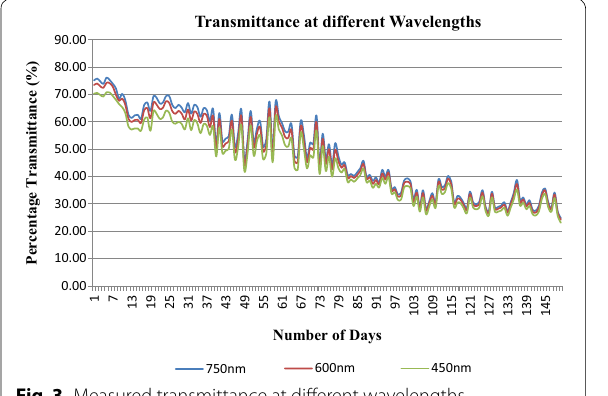
Fig. 3 Measured transmittance at different wavelengths